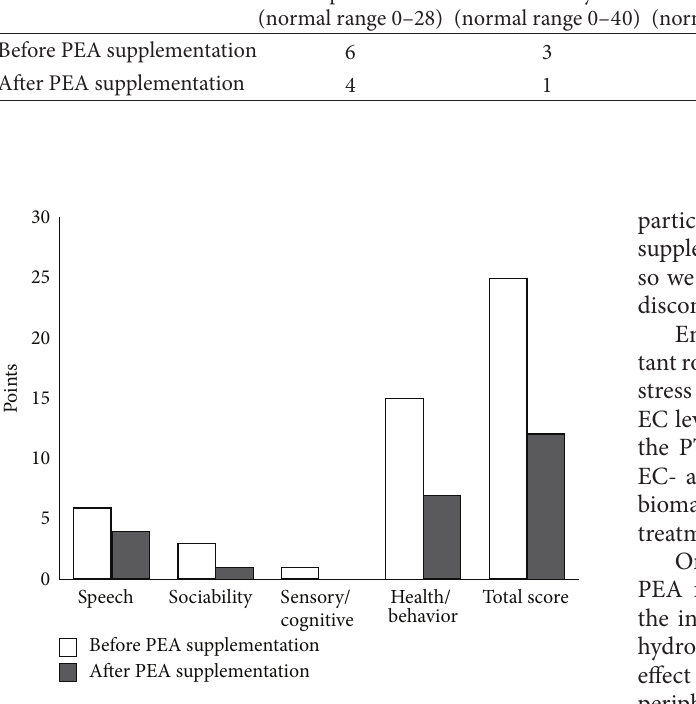
Figure 1: Dynamics on a scale of Autism Treatment Evaluation Checklist (ATEC) in Subject 2 autistic patient before (baseline) PEA supplementation and three months later. The purpose of the ATEC is to measure change in an individual due to various interventions, that is, the difference between the initial (baseline) ATEC scores and later ATEC scores